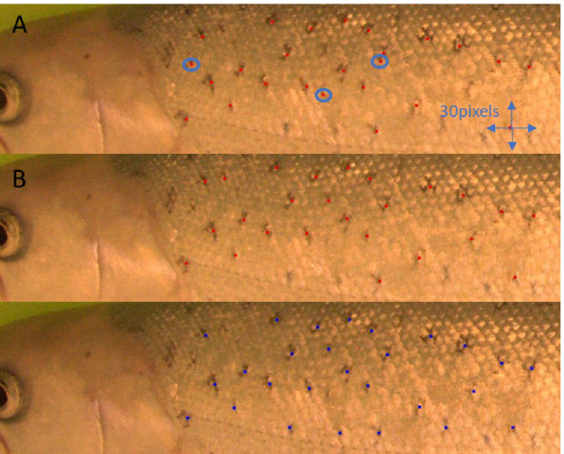
Figure 8. Top and middle images—example of dot detection for two (A and B) images of the same fish. The arrows indicate the pattern shift for alignment. The dots (blue circle) of the A pattern do not have close points in the B pattern, and therefore, they are not used in the representative pattern. Bottom—representative dots selected as a subset of the dots detected for all images of the same